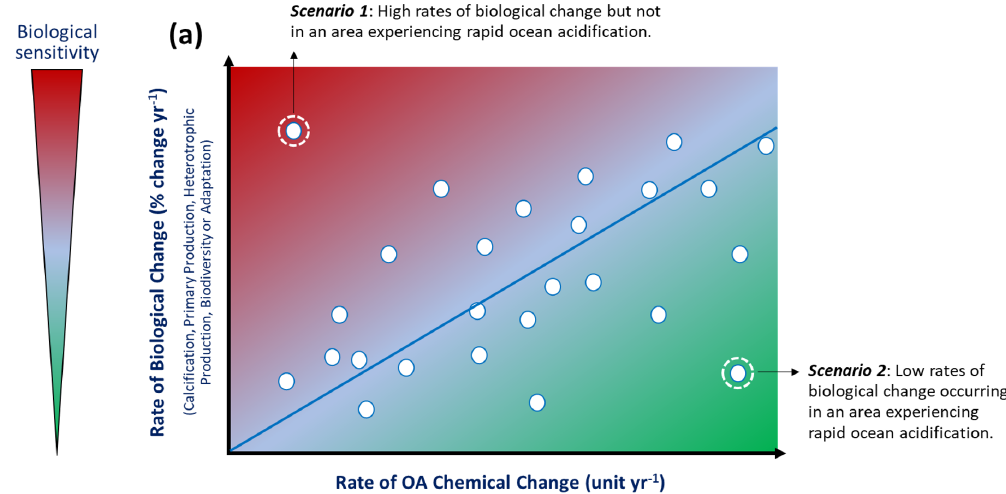
Figure 2. Within each of the five proposed biological impact indicator categories (calcification, primary production, heterotrophic production, biodiversity, adaptation), it is possible to combine the data from numerous individual time series stations in order to compare the rates of chemical change with the rate of biological change across different geographical locations and between different biological contexts. Each individual data point on the graph represents the summary information from a single time series that has coupled biological impact and carbonate chemistry observation data. With enough observations, it is possible to generate a generic relationship (blue line). Using the relative positions of data points on this plot it is possible to derive site-specific information about the relative importance of OA in driving biological change at the individual time series stations. In scenario 1, the biological impact is largely caused by other environmental drivers, or the biological parameter that was measured is highly sensitive to OA. In scenario 2, the measured biological impact parameter is not sensitive to OA, or the biological impact is being mitigated by other environmental drivers or biological